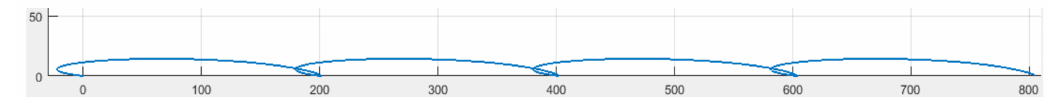
Figure 9. Locus of center of gravity for Case 1.